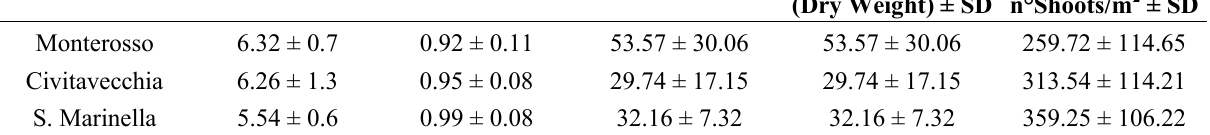
Table 1. Intercomparison between PO meadows phenology parameters derived from sea truth data acquired on Civitavecchia (8 stations) and other two different sites (about 10 stations) of the Tyrrhenian coast. The SD (Standard Deviation) values refer to stations number which is different for each